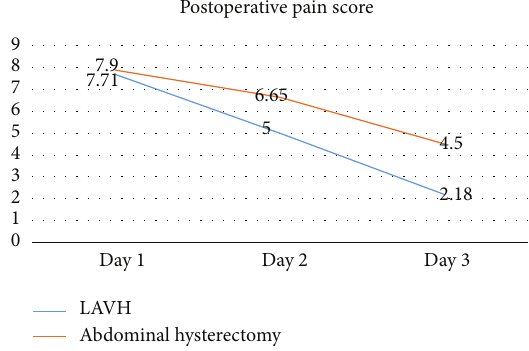
Figure 1: Pain scores among the two methods following surgery.